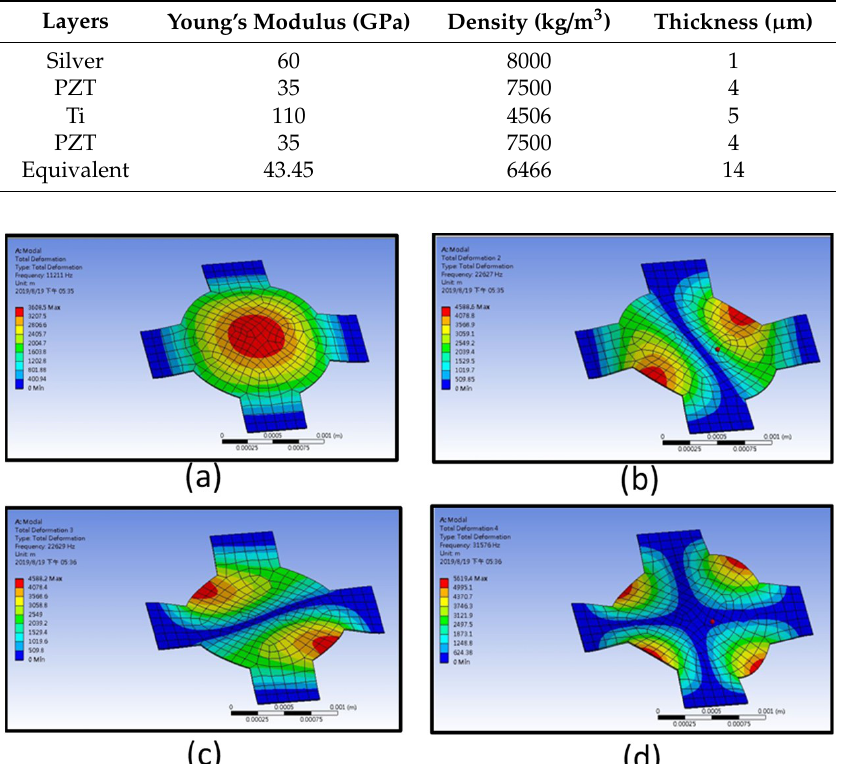
Figure 2. Finite element analysis (FEA) results: ( a ) the fundamental mode shape, ( b ) the second order Figure 2. FEA results: ( a ) the fundamental mode shape, ( b ) the second order harmonic mode shape, harmonic mode shape, ( c ) the third order harmonic mode shape, and ( d ) the fourth order harmonic ( c ) the third order harmonic mode shape, and ( d ) the fourth order harmonic mode shape. mode